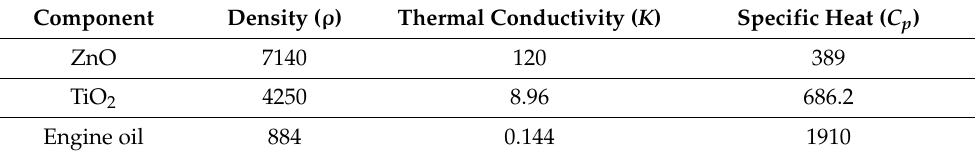
Table 1. Thermo-physical properties of nanoparticles (ZnO, TiO 2 ) and base fluid engine oil.